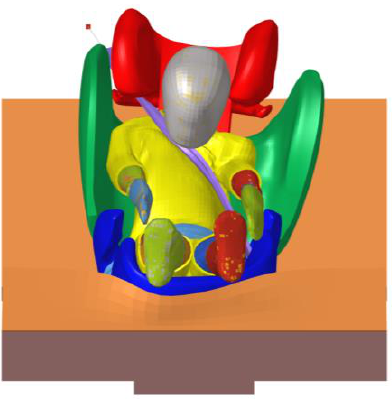
Figure 6. Layout of a Child Restraint System.